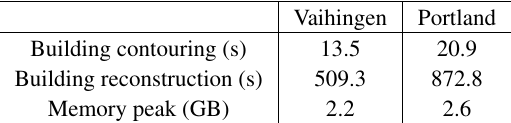
Table 3. Performance measures for datasets Vaihingen and